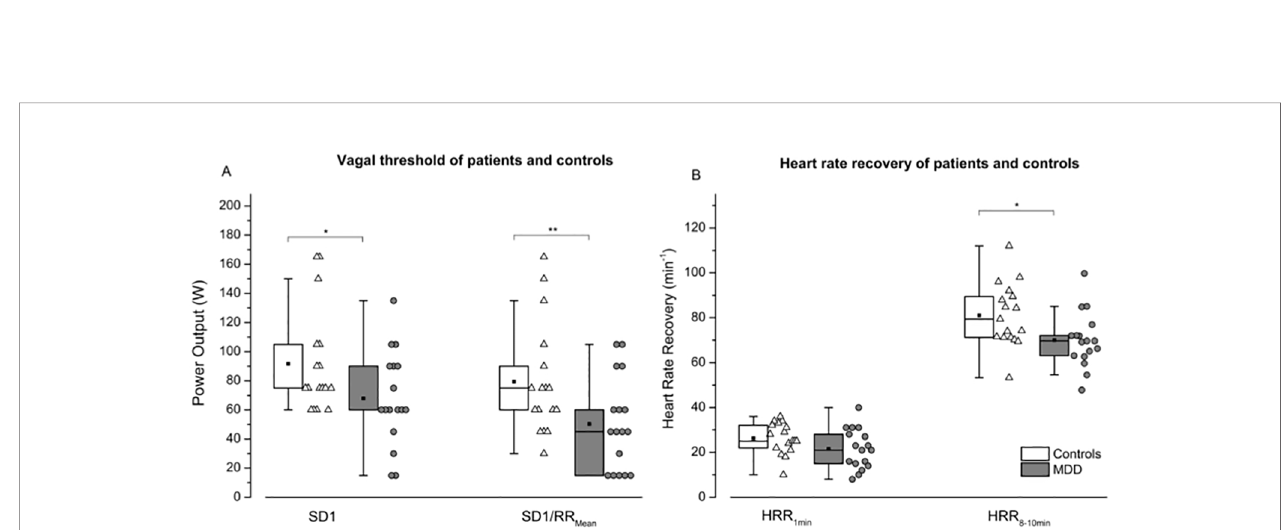
FIGURE 4 | Vagal threshold (A) and heart rate recovery (B) are shown for controls (white boxes resp. triangles) and patients (grey boxes resp. points) following maximal exercise. SD1: instantaneous variability; SD1/RR Mean: SD1normalized by mean RRI; HRR 1min : Heart rate recovery 1 min after exercise secession; HRR 8-10min : Heart rate recovery 8 – 10 minutes after exercise secession. Boxes indicate data between the 25th and 75th percentile with the horizontal bar re fl ecting the median ( ▪ = mean; – = 1.5 x interquartile range). Signi fi cant differences of pair-wise comparisons are indicated: *P < 0.05; **P < 0.01.